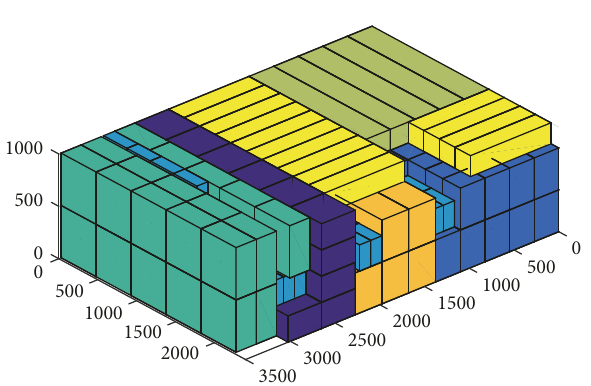
Figure 13: Packing result in